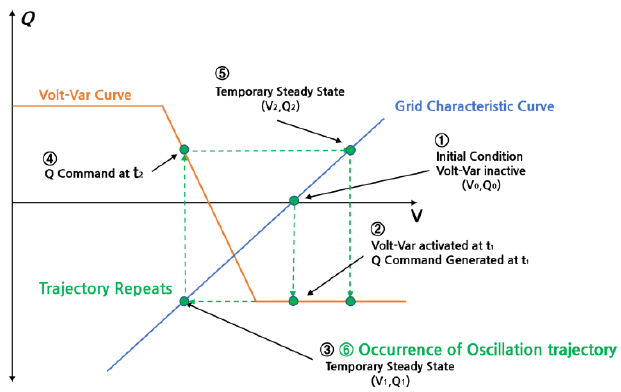
Figure 3. Unstable VVC operation (oscillation).